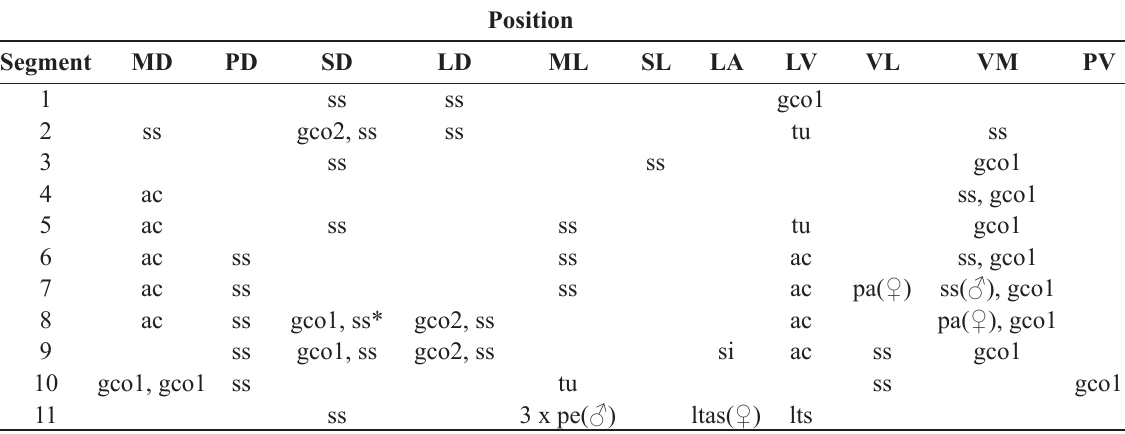
Table 13. Summary of nature and location of sensory spots, glandular cell outlets, tubes and spines arranged by series in Echinoderes lupherorum sp. nov. Abbreviations: LA = lateral accessory; LD = laterodorsal; LV = lateroventral; MD = middorsal; ML = midlateral; PD = paradorsal; PV = paraventral; SD = subdorsal; SL = sublateral; VL = ventrolateral; VM = ventromedial; ac = acicular spine; gco1/2 = glandular cell outlet type 1/2; ltas = lateral terminal accessory spine; lts = lateral terminal spine; pa = papilla; pe = penile spines; si = sieve plate; ss = sensory spot; tu = tube; ( ♀) = female and ( ♂ ) = male conditions of sexually dimorphic characters. * = indicates that the structure is not present in all